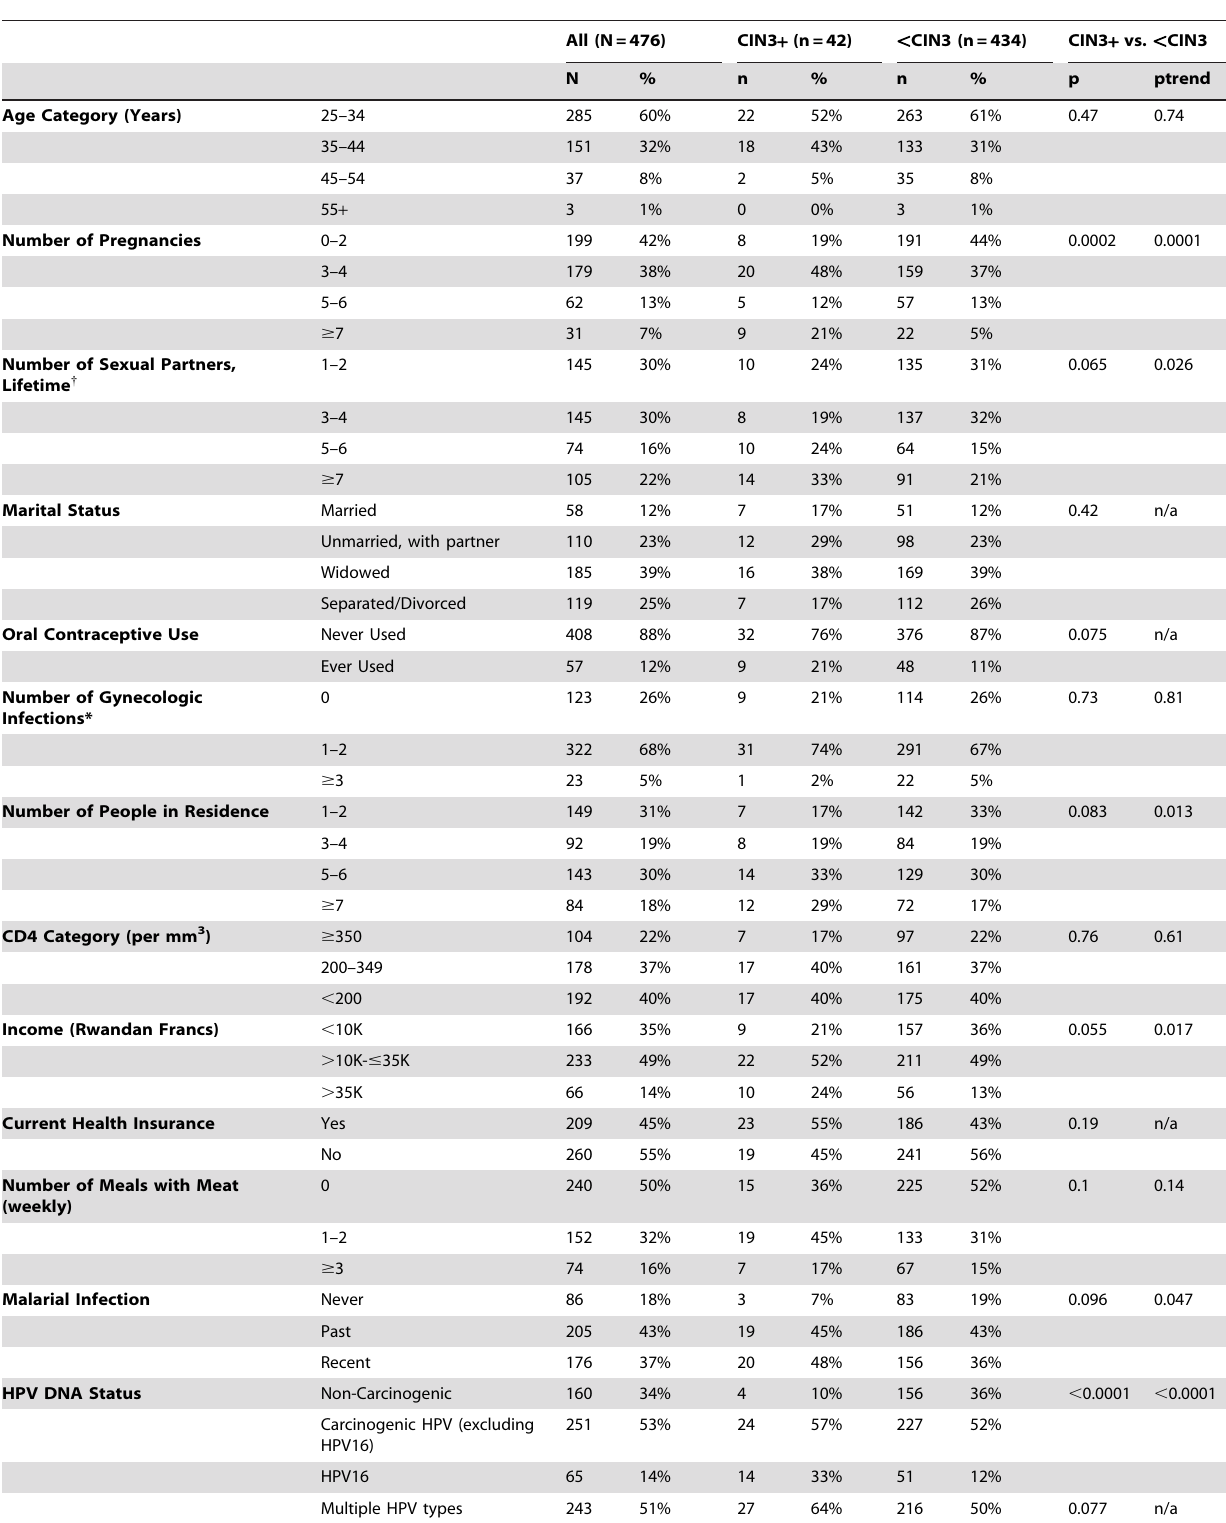
Table 1. Demographic and clinical characteristics in human immunodeficiency virus-infected, human papillomavirus (HPV)- infected women with and without cervical intraepithelial neoplasia grade 3 (CIN3) or cancer (CIN3 +